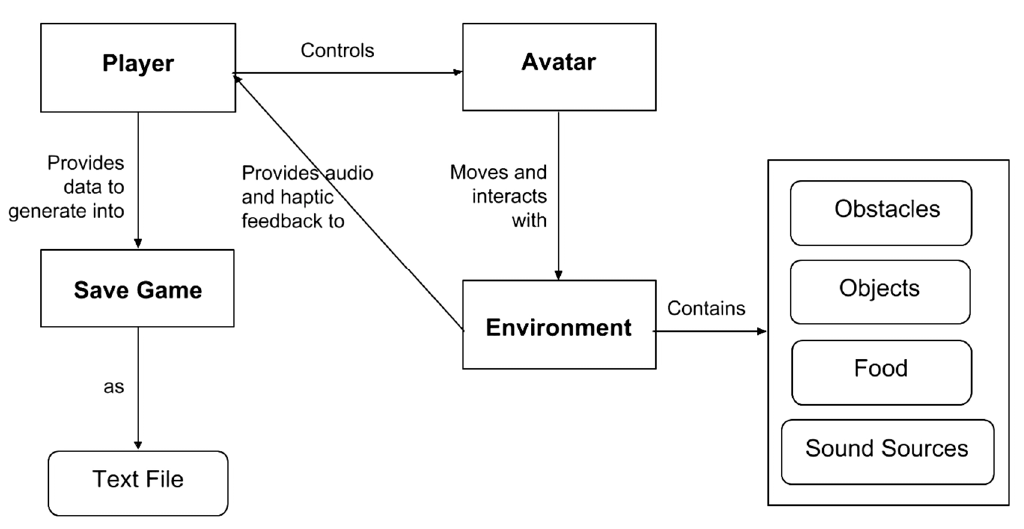
Figure 1. Conceptual architecture of Hungry Cat.